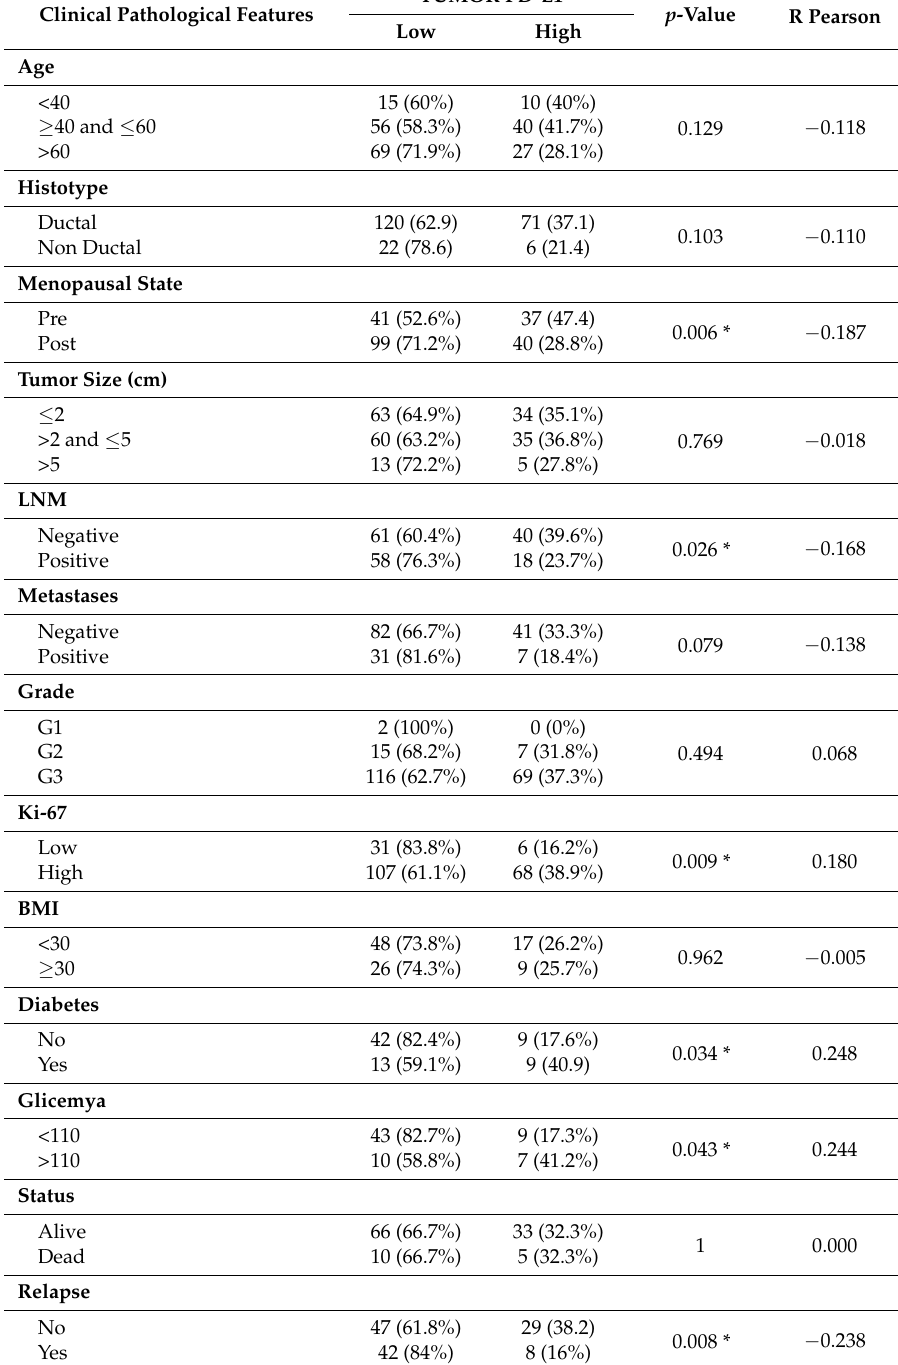
Table 1. Statistical associations between PD-L1 tumor expression and clinical pathological features of Triple Negative Breast Cancers (TNBC) samples. (*) indicates statistical